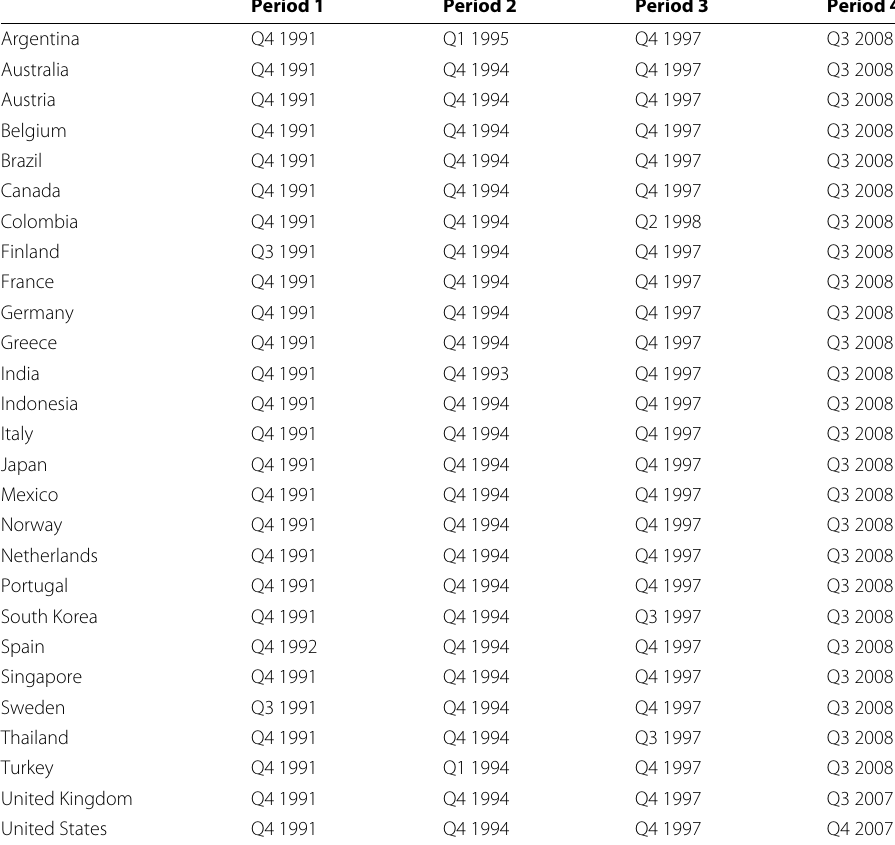
Table 2 Reference Dates for Assessment Periods